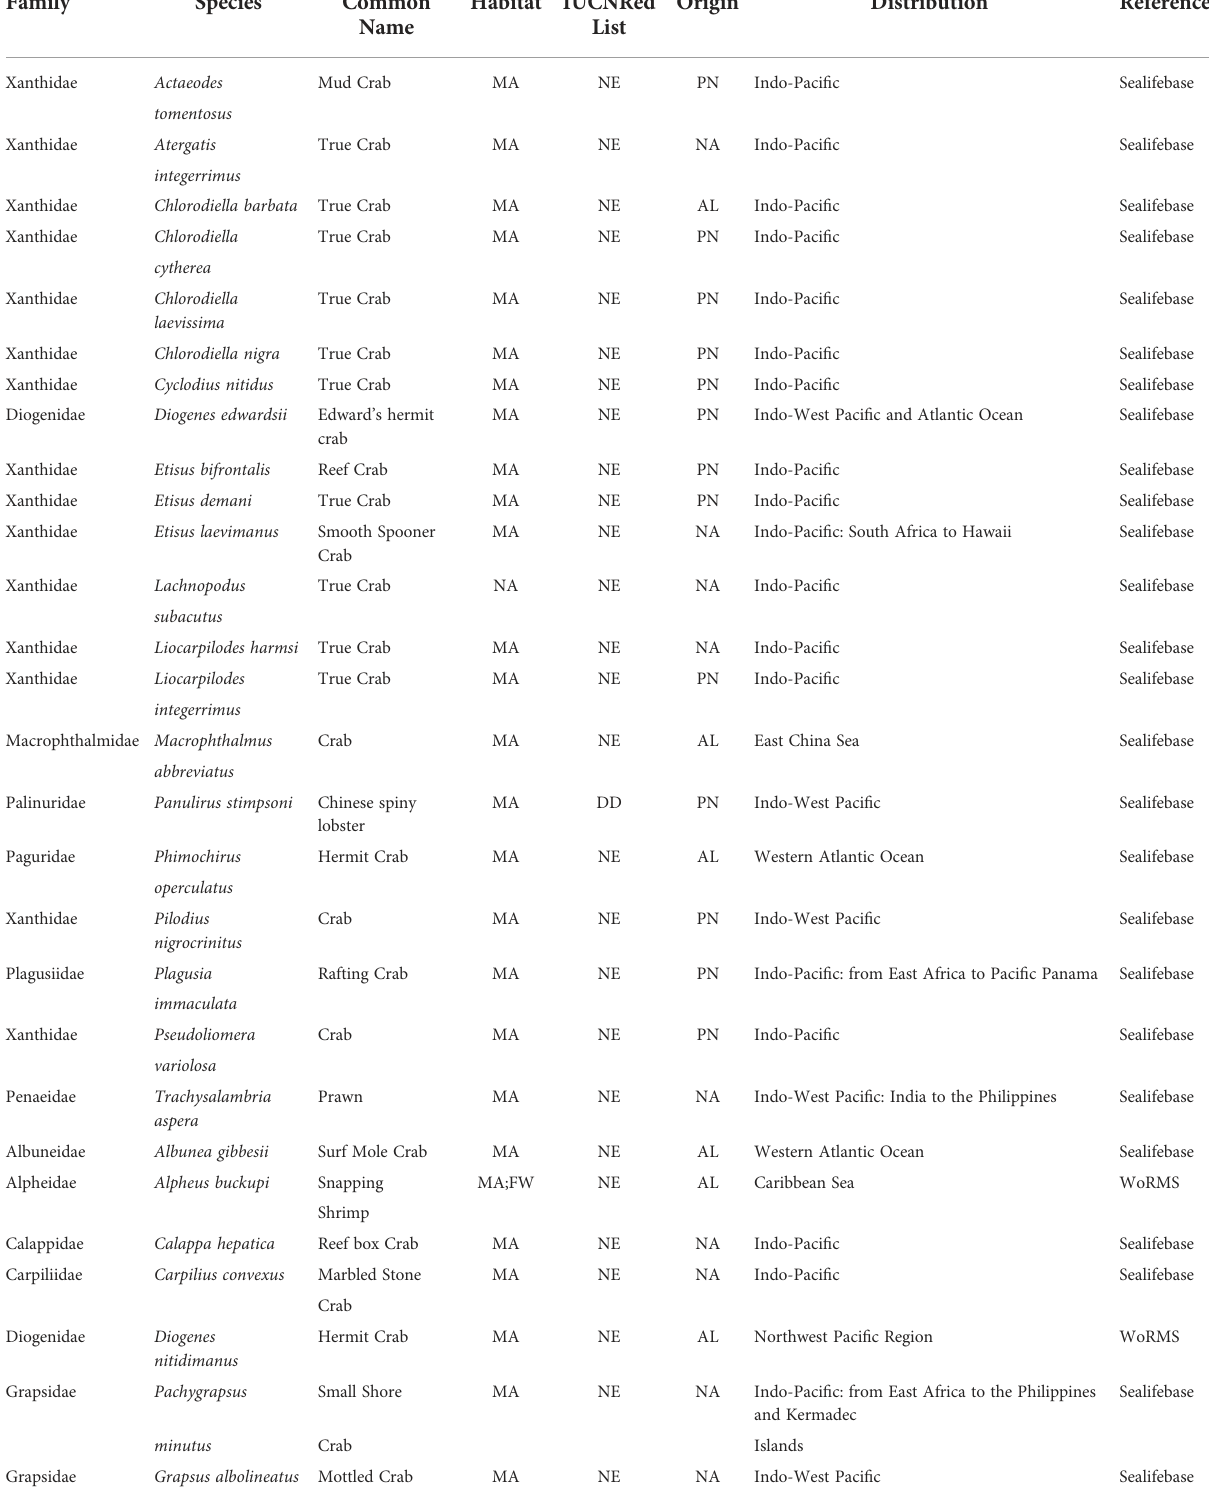
TABLE 1 Status of decapod crustaceans based on Habitat.